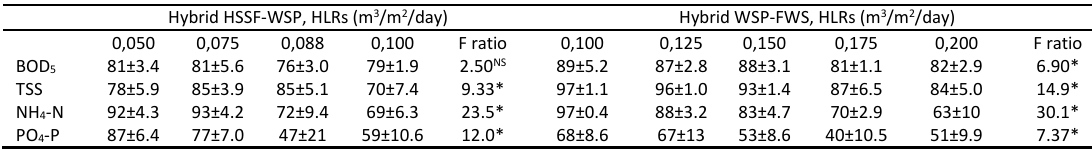
Table 4 . Mean (±1 SD, n = 6) pollutant removal efficiencies (%) at the different hydraulic loading rates and results of one-way ANOVA statistic (F-ratio). Hybrid HSSF-WSP, HLRs (m 3 /m 2 /day)